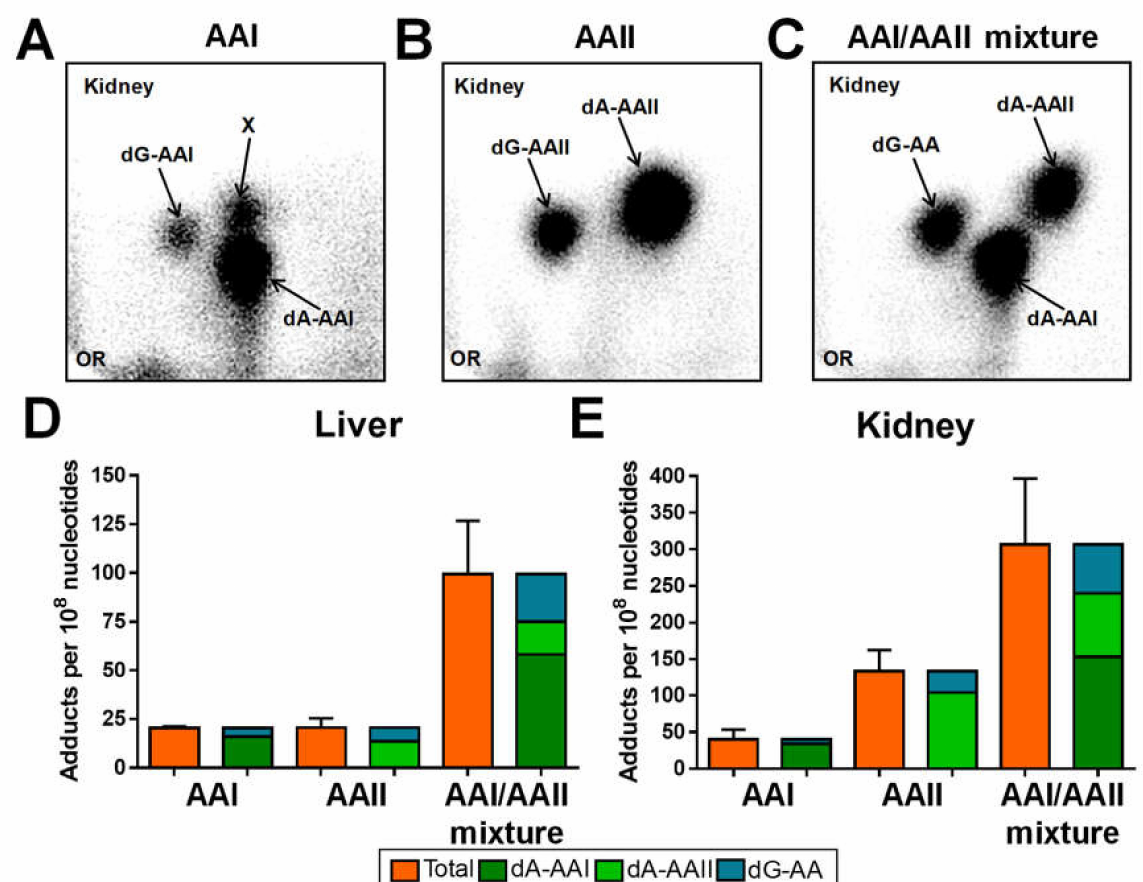
Figure 2. Representative autoradiograms of DNA adducts, measured by 32 P-postlabelling, in kidney tissue samples of rats treated with AAI ( A ), AAII ( B ) or AAI/AAII mixture ( C ). These profiles are representative of adduct pattern obtained with DNA from liver tissue samples of the same rats. The origin (OR) on the TLC plate, shown in the bottom left-hand corners, was cut off before imaging. Note:: 7-(deoxyadenosin- N 6 -yl)-aristolactam I (dA-AAI); 7-(deoxy- guanosin- N 2 - yl)-aristolactam I (dG-AAI); 7-(deoxyadenosin- N 6 -yl)-aristolactam II (dA-AAII); 7-(deoxy- guanosin- N 2 -yl)-aristolactam II (dG-AAII); dG-AA, mixture of dG-AAI and dG-AAII; X, unknown adduct whose chemical structure has not yet been identified. Total DNA adduct levels measured by quantitative 32 P-postlabelling analysis in liver ( D ) and kidney ( E ) tissues of rats treated with AAI, AAII or AAI/AAII mixture. All values are given as the means ± SD ( n = 2). Note the different scaling levels when comparing AA-DNA adduct levels in liver and kidney tissue